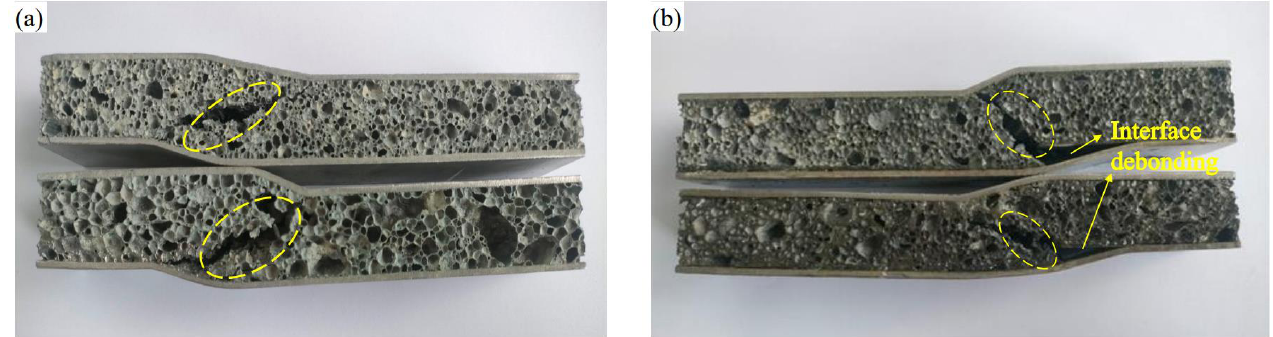
Figure 9. Fatigue fracture diagram of AFSs: ( a ) the powder metallurgy method, ( b ) the adhesive method.